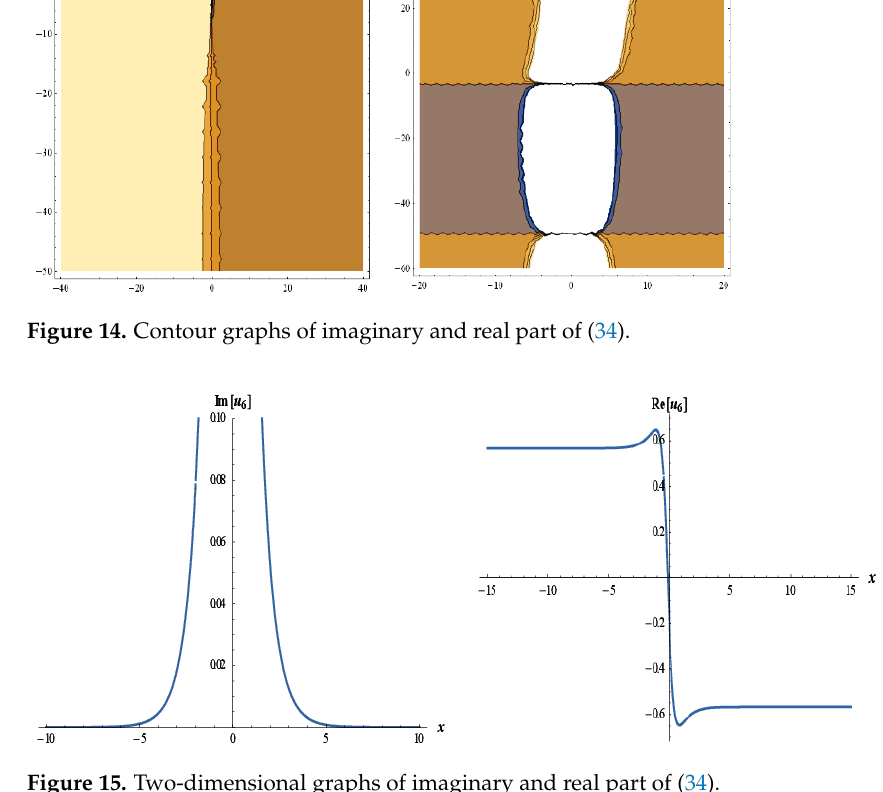
Figure 15. Two-dimensional graphs of imaginary and real part of